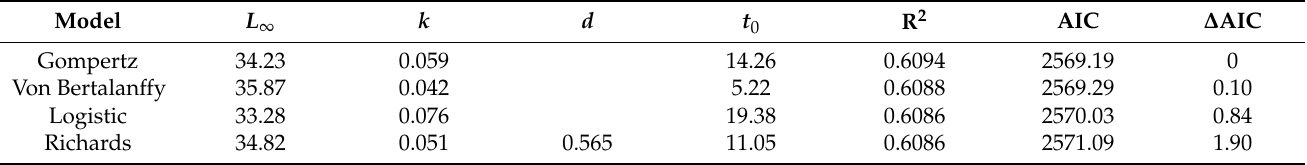
Table 2. The parameter estimates and comparison of the growth models for larval and juvenile